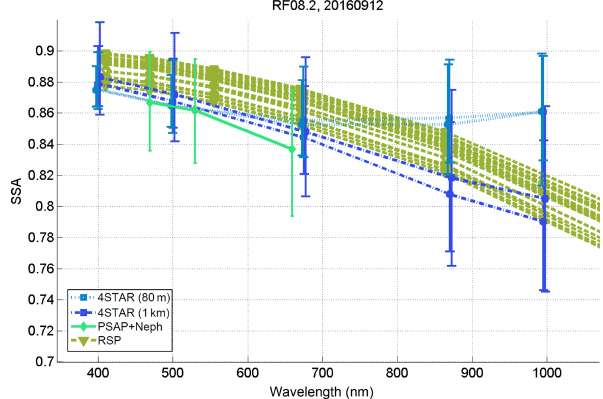
Figure 4. Spectral SSA from 4STAR (blue squares), RSP (golden- rod triangles), and in situ (green diamonds) calculations for the case on 12 September 2016. This case was centered at approximately 18.0 ◦ S, 8.0 ◦ E, between 13:44 and 14:34UTC. The bars on the in situ measurements represent the 10th–90th percentile ranges for the profile considered. The two 4STAR curves with high SSA 995nm are from the 80m altitude scans, while the curves with low SSA 995nm curves are from the 1km altitude